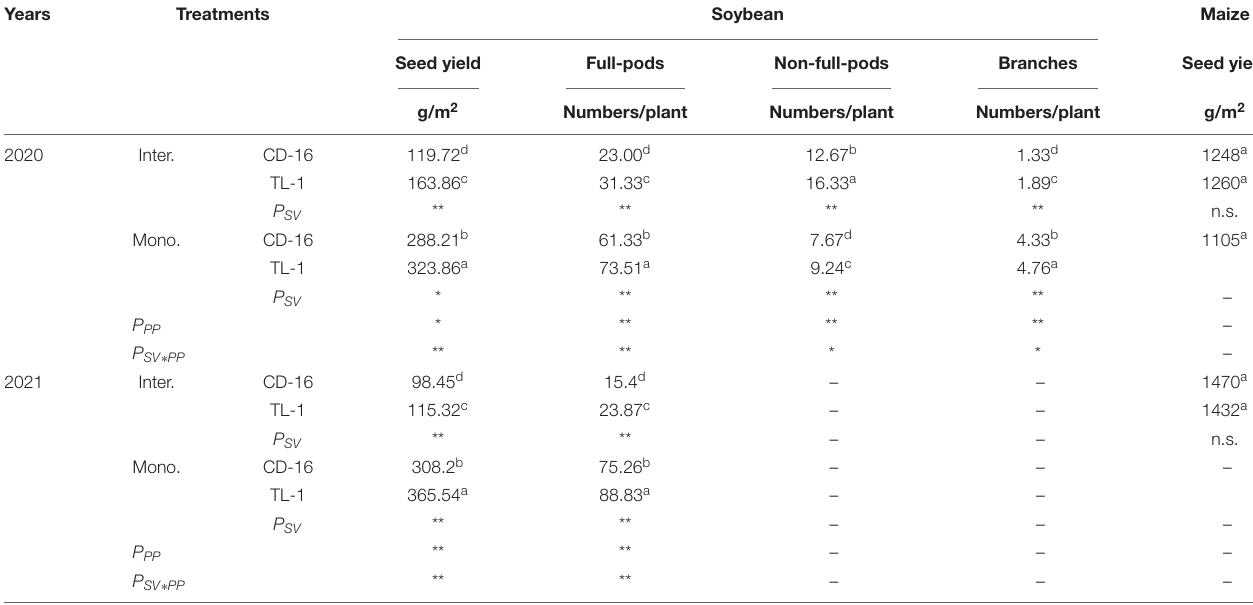
TABLE 2 | The seed yield and composition of soybean and maize yield response to soybean cultivars and patterns in 2020 and 2021. Years